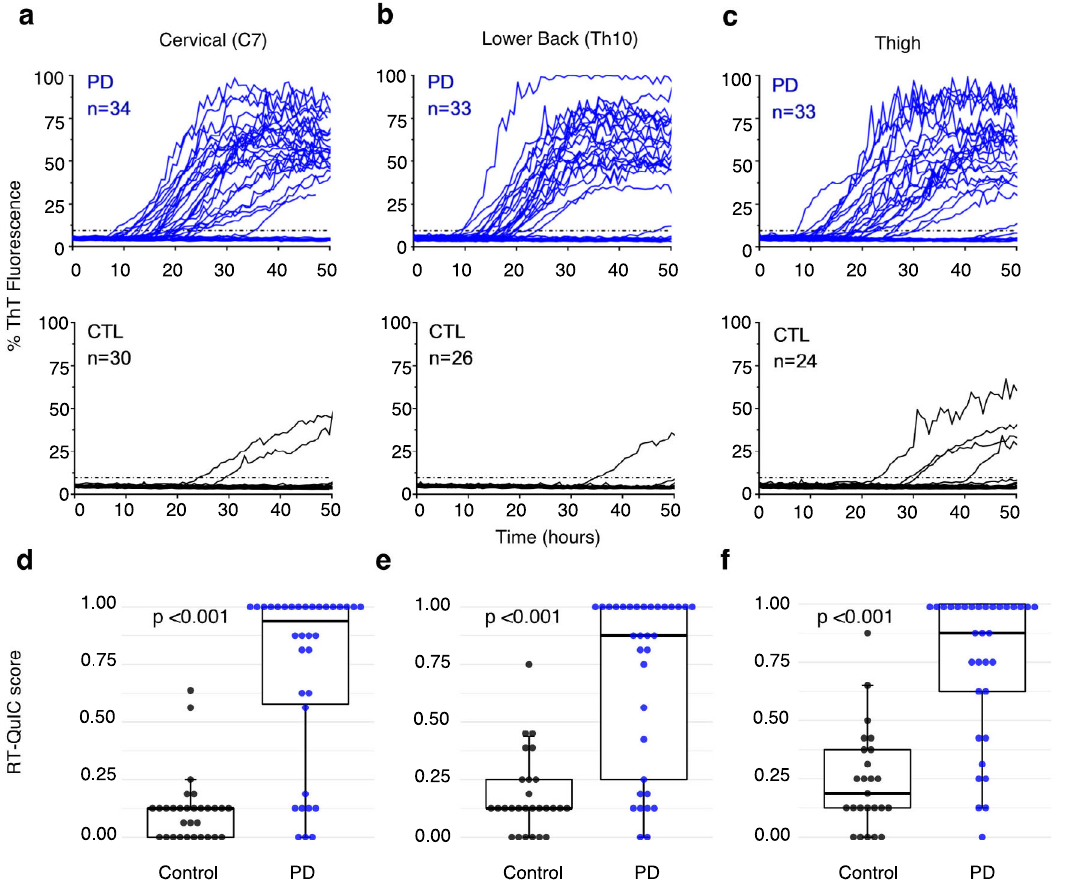
Fig. 2 Higher α -syn seeding activity in skin biopsies from different anatomical sites in PD patients as compared to control subjects. a – c show RT-QuIC reactivity in skin biopsies of PD patients and controls collected at the locations of cervical C7, lower back Th10, and thigh, respectively. ThT fl uorescence from individual skin biopsies is more intense and occurs more frequently in PD (blue curves) than in controls (CTL, black curves) above the threshold of 9.6% (dotted lines). Raw data are taken from the Cleveland center. d – f illustrate the RT-QuIC scores for individual skin biopsies in PD and control groups collected at cervical C7 ( d ), thoracal Th10 ( e ), and thigh ( f ). Scores are pooled from both Cleveland and Würzburg centers. The box plots demonstrate signi fi cantly higher scores in PD patients compared to controls ( p < 0.001). The boxes represent the interquartile range (IQR) with the median line and the whiskers extending to the most extreme data point, which is no more than 1.5 times of